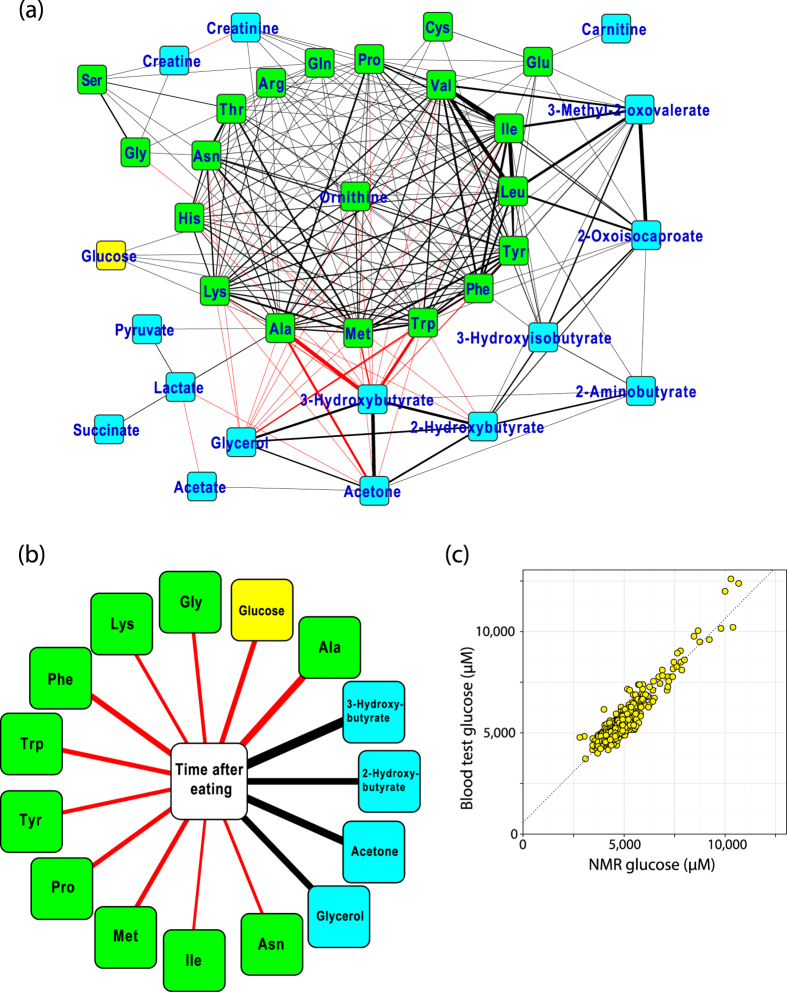
Correlation analyses.(a) Correlations between the quantified metabolites. Each node and each edge represent a metabolite and the metabolite pairs with log10(P-value) <−10, respectively. Positive and negative correlations are represented using black and red lines, respectively. Thicker lines represent stronger correlations between two metabolite levels. This figure was generated using Cytoscape v3.2.142. (b) Correlations between time after eating and the quantified metabolites. Each node represents a metabolite or time after eating, and each edge represents the pairs with log10(P-value) <−10. Positive and negative correlations were represented same as (a). (c) Correlation between the plasma glucose concentration quantified by NMR and that from the blood test.